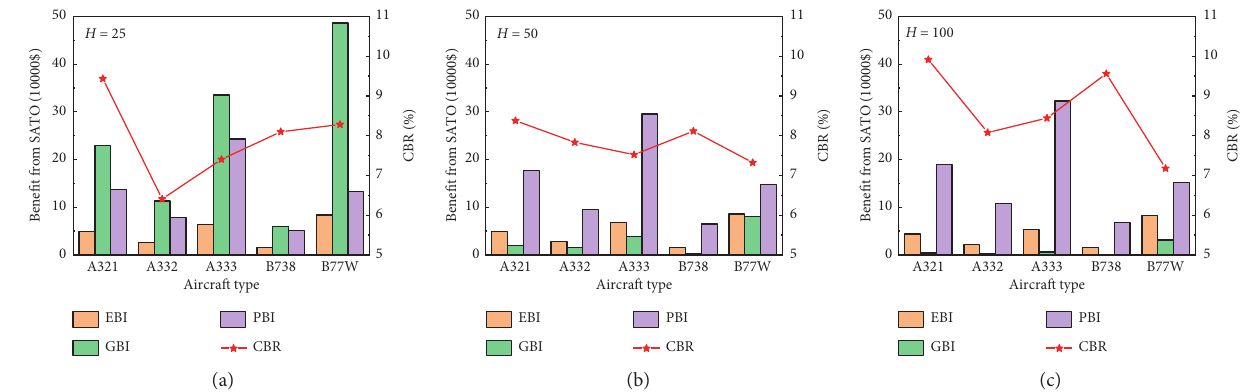
Figure 7: Monthly EBI, GBI, PBI, and CBR classified by aircraft type with different time